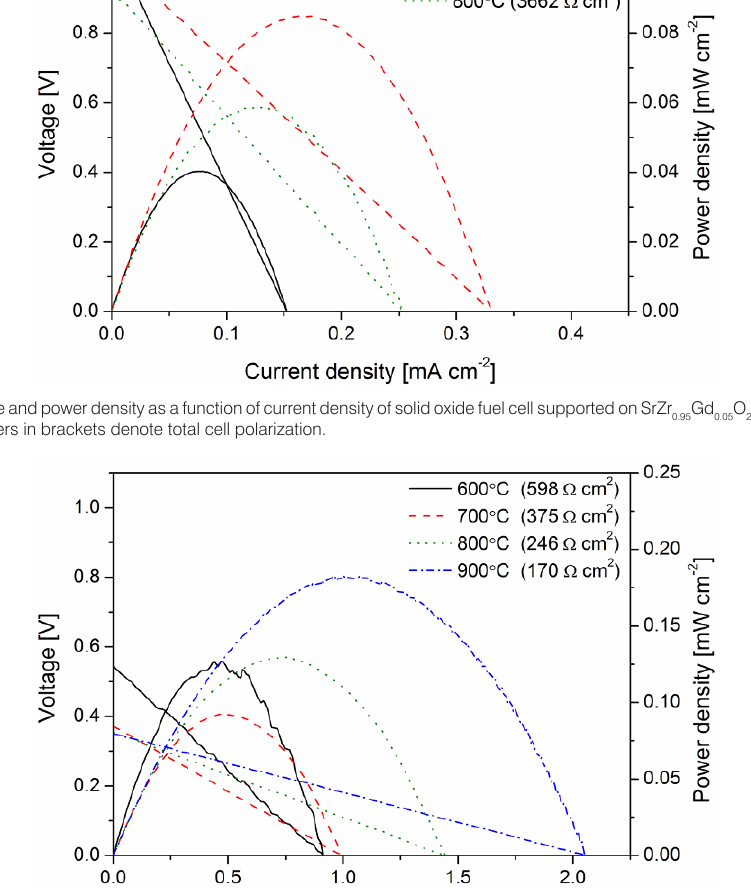
Gd O electrolyte 0.95 0.05 2.975